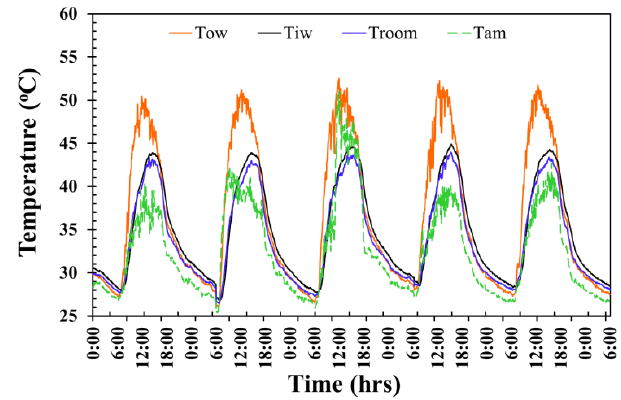
Figure 8. Temperature evolution of the AAC-2H testing room wall.